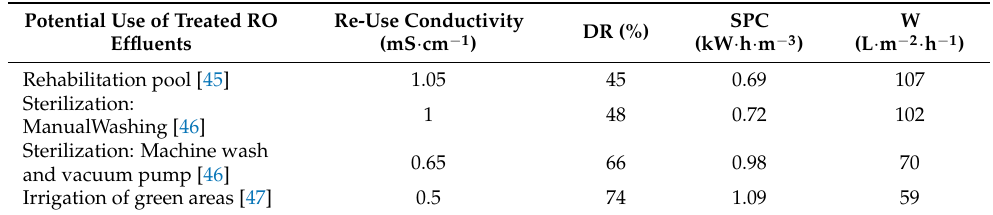
Table 4. Relevant performance parameters to achieve water quality standards for each reuse of dialysis RO